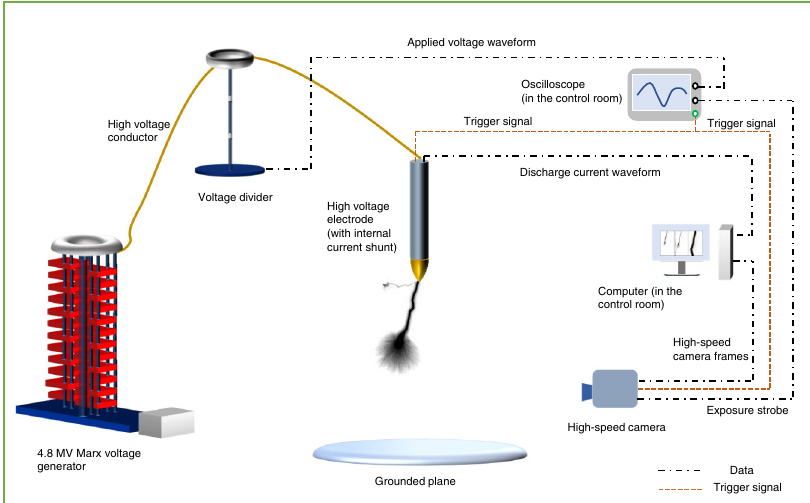
Fig. 7 The experimental setups. The experiments were conducted indoors. The length of the high voltage electrode is 2 m, and the gap scale is adjustable between 0 and 8 m. A voltage divider was used to measure the applied voltage Measurement . A low-inductance shunt with an equivalent resistance of 5 Ω was mounted on the rod electrode to measure the discharge current. The main perfor- mance parameters of the current measurement system were as follows: − 3dB fre- quency bandwidth, DC to 18.3MHz; sample rate, 2GHz. High-speed cameras were used to record the development of leaders. The distance between the high-speed camera and the gap is varied for different gap lengths to guarantee that the fi eld of view ful fi lls the requirement. To synchronize all experimental data in one discharge event, when the oscilloscope measuring the applied voltage waveforms was triggered, a 5V TTL (Transistor-Transistor Logic) impulse generated by the oscilloscope was sent to the current measurement system and the high-speed video camera as a triggering signal. The trigger delay was pre-measured before the experiment. The temperature and relative humidity during the experiments were measured by a HOBO MX1101 temperature/relative humidity data logger. The accuracy of the instrument is as follows: ±0.2 °C and ±2% RH. The absolute humidity was calculated from the relative humidity and temperature measured.